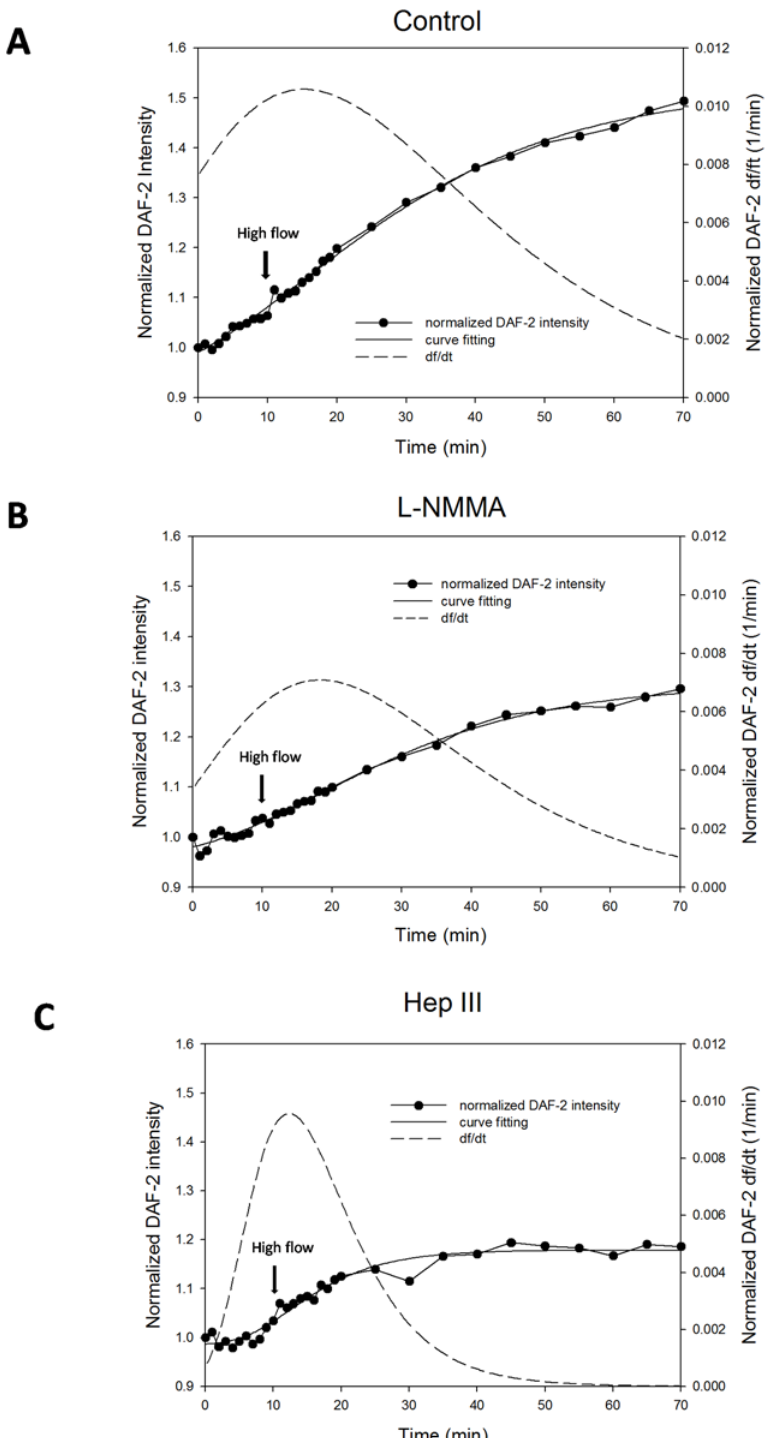
Figure 4. Curve fitting for the flow-induced increases in NO production (DAF-2 intensity normalized by that after 45min DAF-2 DA loading) (smooth solid line) and production rate (df/dt) (dashed line) in post-capillary venules. A) control (1% BSA Ringer); B) in the presence of L-NMMA; and C) 1 h pretreatment of heparinase III. The filled circles are the measured data.